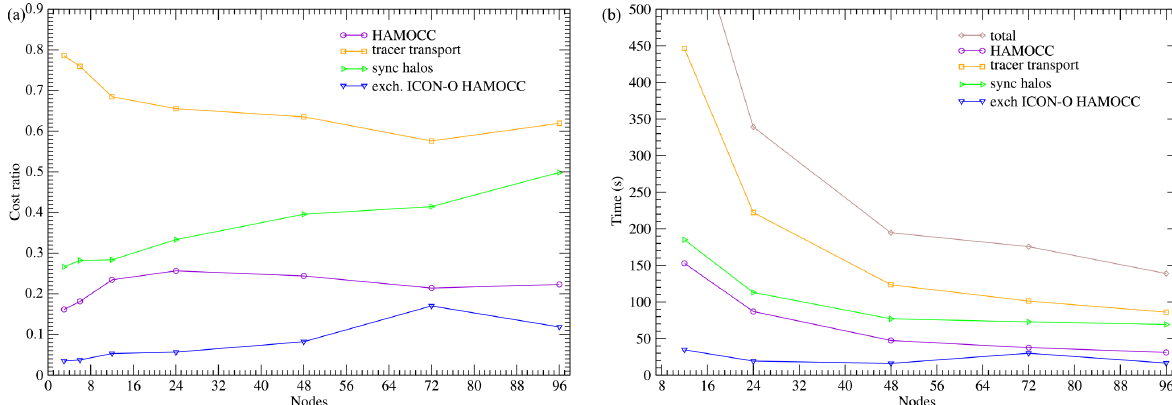
Figure 16. (a) Relative costs for the HAMOCC components in the concurrent 40km setup. (b) Run times for each component.